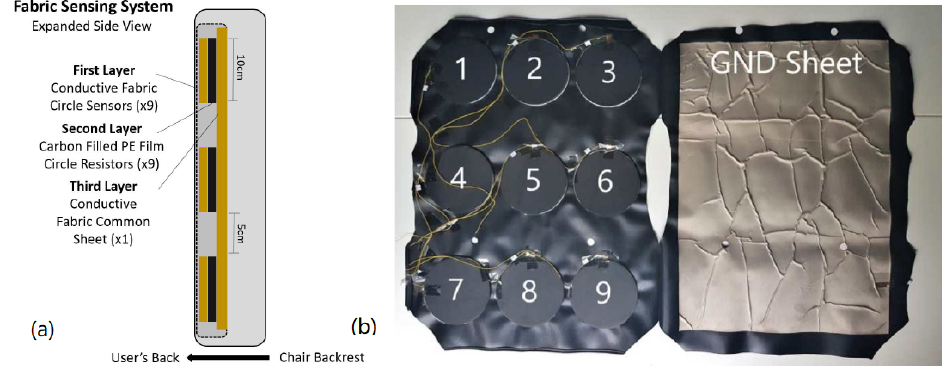
Figure 2. ( a ) Description of material layers in the proposed pressure sensing system; ( b ) fabric sensing system composed primarily of conductive fabrics (Ni, Cu and polyester) and conductive film. The left side shows the sensors with the conductive film visible; the fabric cloth is beneath the film. The right side shows the common fabric